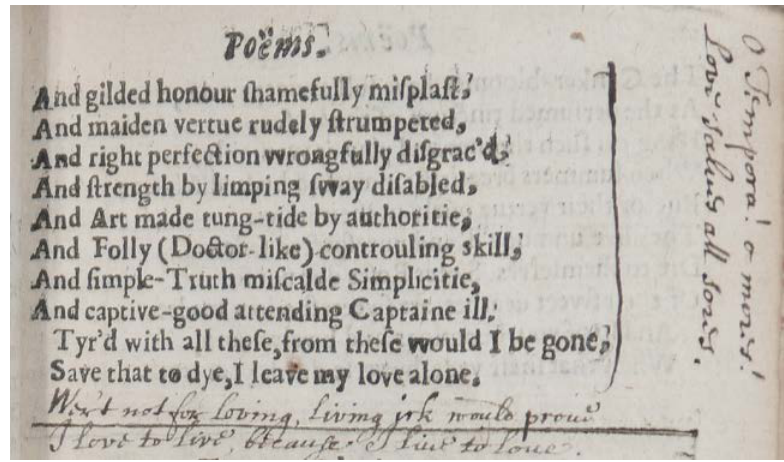
Fig. 11 – Folger STC 22344 Copy 2, sig.